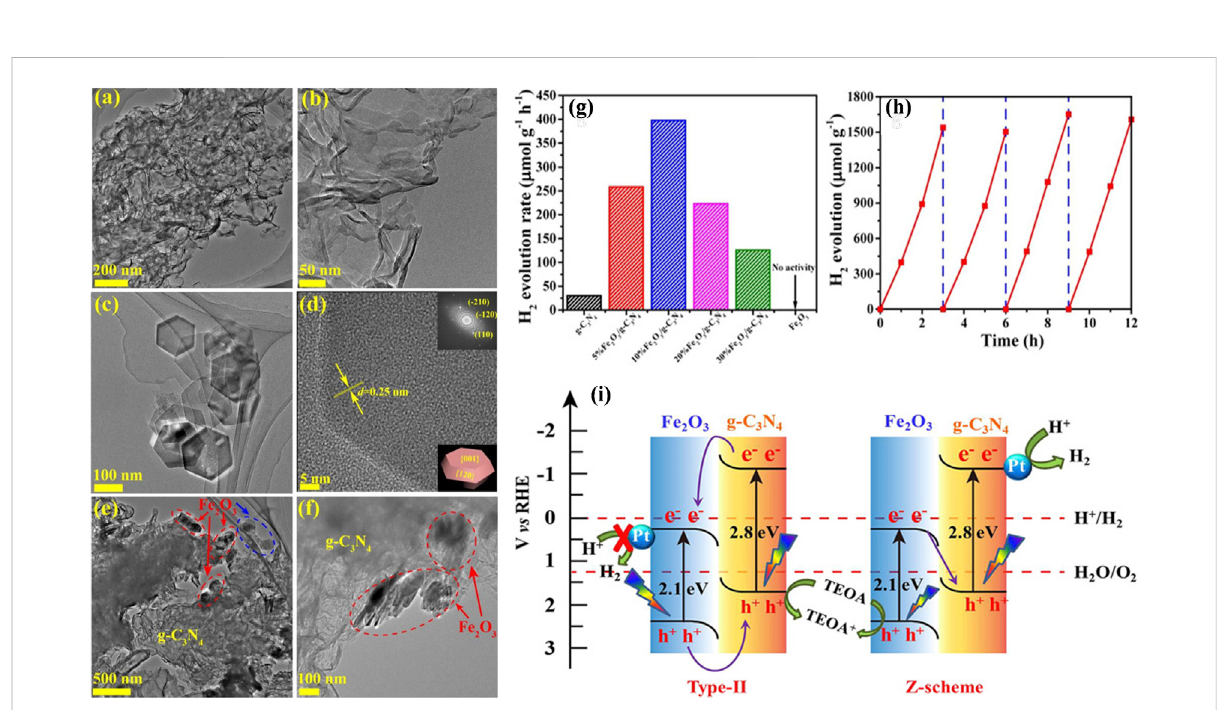
FIGURE 5 TEMphotosof2DFe 2 O 3 /g-C 3 N 4 (A,B) and2Dg-C 3 N 4 (C) .HRTEMimageofFe 2 O 3 (D) andthesampleswith10%Fe 2 O 3 /g-C 3 N 4 (E,F) .Theupper right corner inset part of the image (D) shows Fe 2 O 3 nanoplate FFT pattern; in contrast, the lower right corner is a depiction of Fe 2 O 3 nanoplate facets. (G) Photocatalytic activities demonstration by g-C 3 N 4 nanosheets, Fe 2 O 3 , and 2D Fe 2 O 3 /g-C 3 N 4 heterostructure, (H) the stability of 10% sample Fe 2 O 3 /g-C 3 N 4 heterostructure with visible-light of λ > 420 nm irradiation, (I) Charge transfer mechanism of traditional type-II heterojunction and direct Z-scheme. Reproduced with permission from Xu et al. (2018), Copyright 2018 Wiley Online